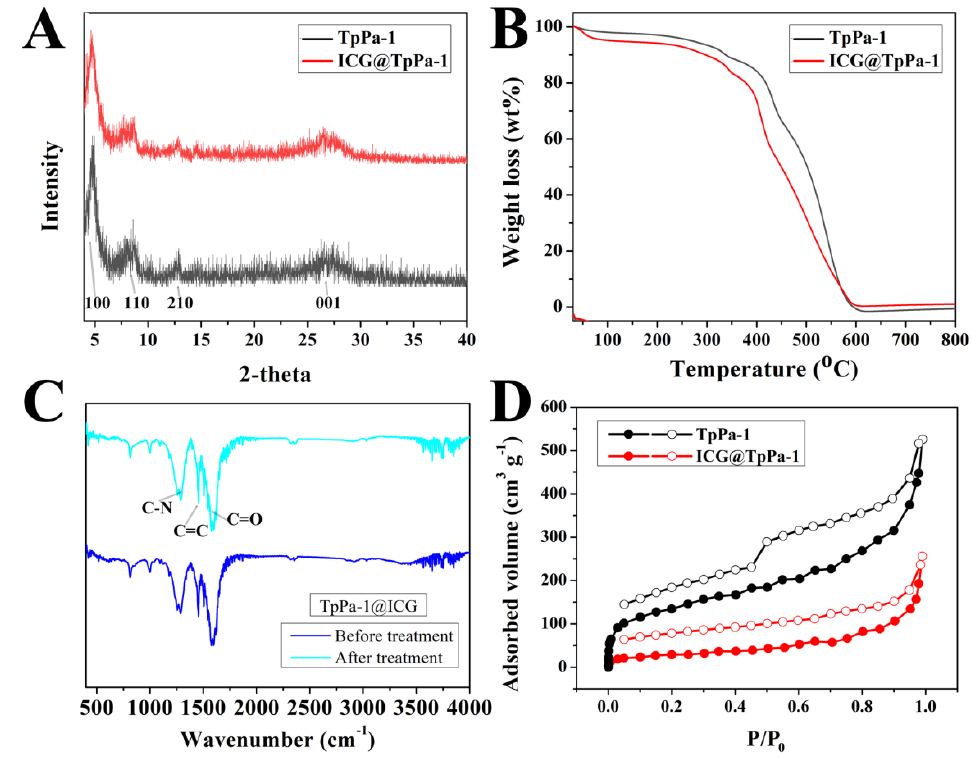
Figure 1. PXRD patterns ( A ) and TGA curves ( B ) of TpPa − 1 and TpPa − 1@ICG. FT-IR spectra ( C )